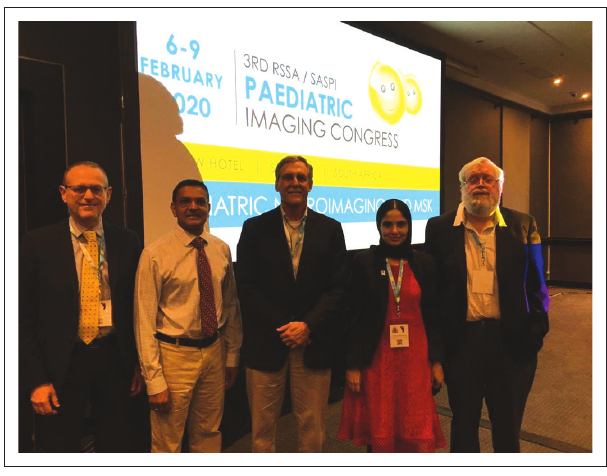
FIGURE 2: Photograph taken by Antfarm, 08 February 2020, Johannesburg, published with permission from